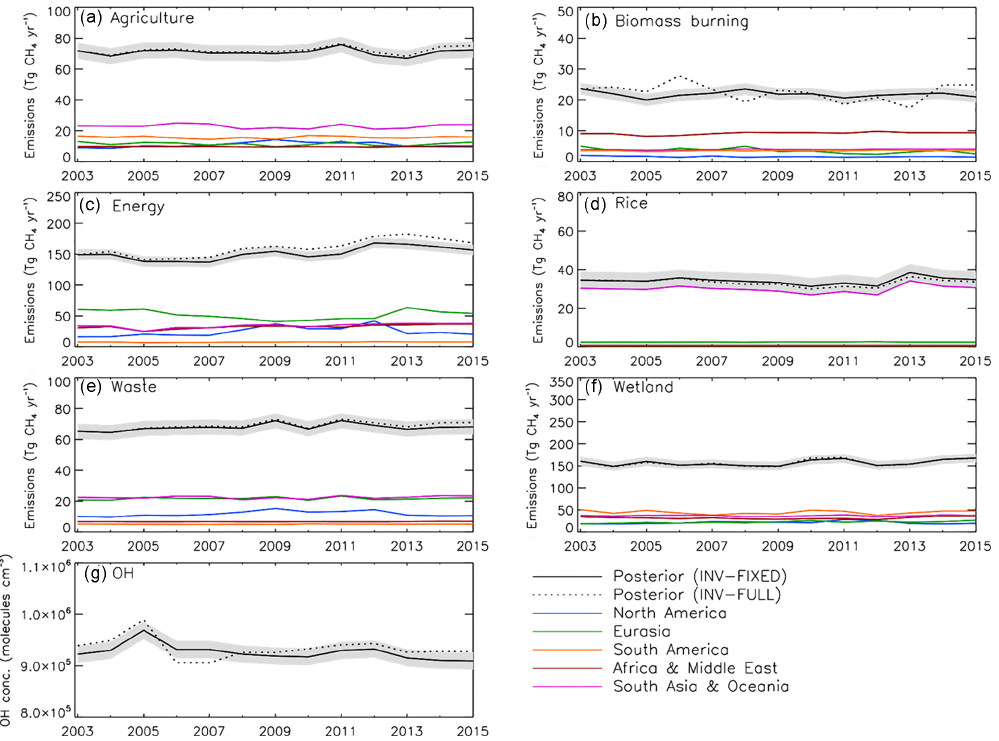
Figure 9. (a–f) Annual CH 4 emissions (TgCH 4 yr − 1 ) from different sectors for INV-FIXED (black solid line) and INV-FULL posterior (black dotted line) estimates. Regional estimates are also displayed for North America (blue), Eurasia (green), South America (orange), Africa and the Middle East (red), and South Asia and Oceania (purple). (g) INV-FIXED (black solid line) and INV-FULL (black dotted line) posterior global OH estimates (moleculescm − 3 ) for the same period. Shaded region denotes posterior error A (see Eq. 5 in